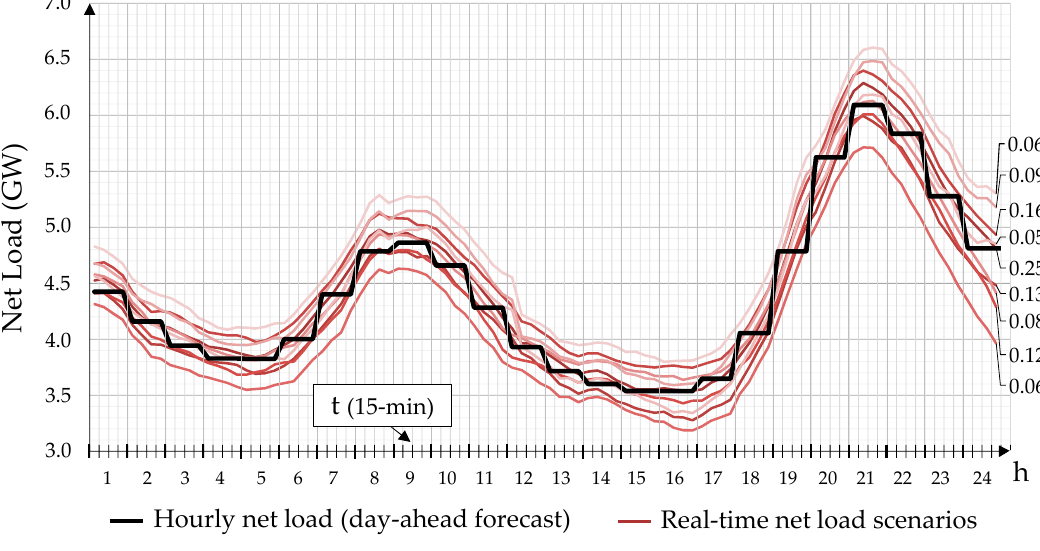
Figure 2. Net load: Day-ahead forecast and real-time scenarios with probabilities.